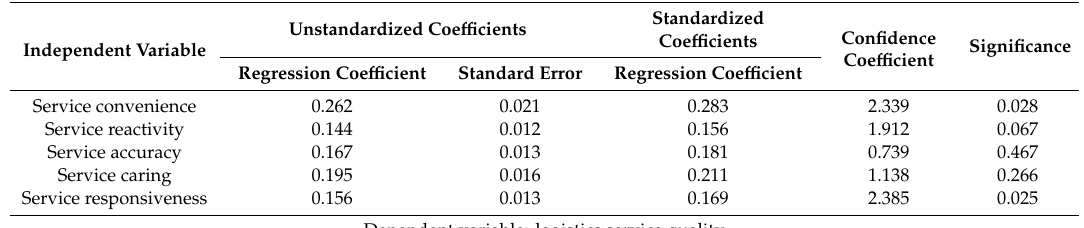
Table 2. Regression analysis of five dimensions.